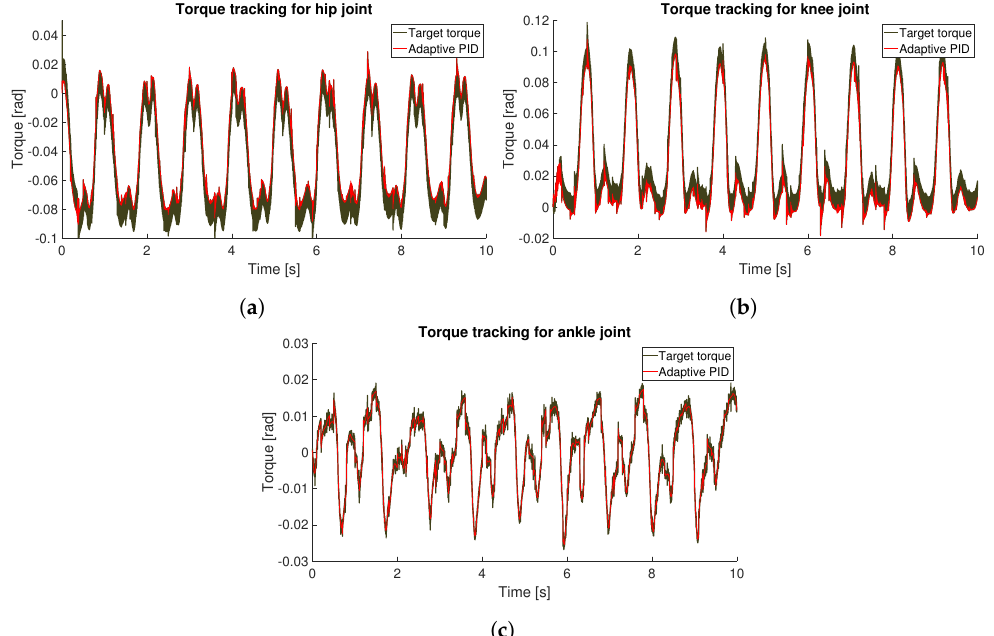
Figure 7. Comparison of the control evolution for the tracking problem based on the application of the adaptive controller (red) for the hip ( a ), knee ( b ) and ankle ( c ).